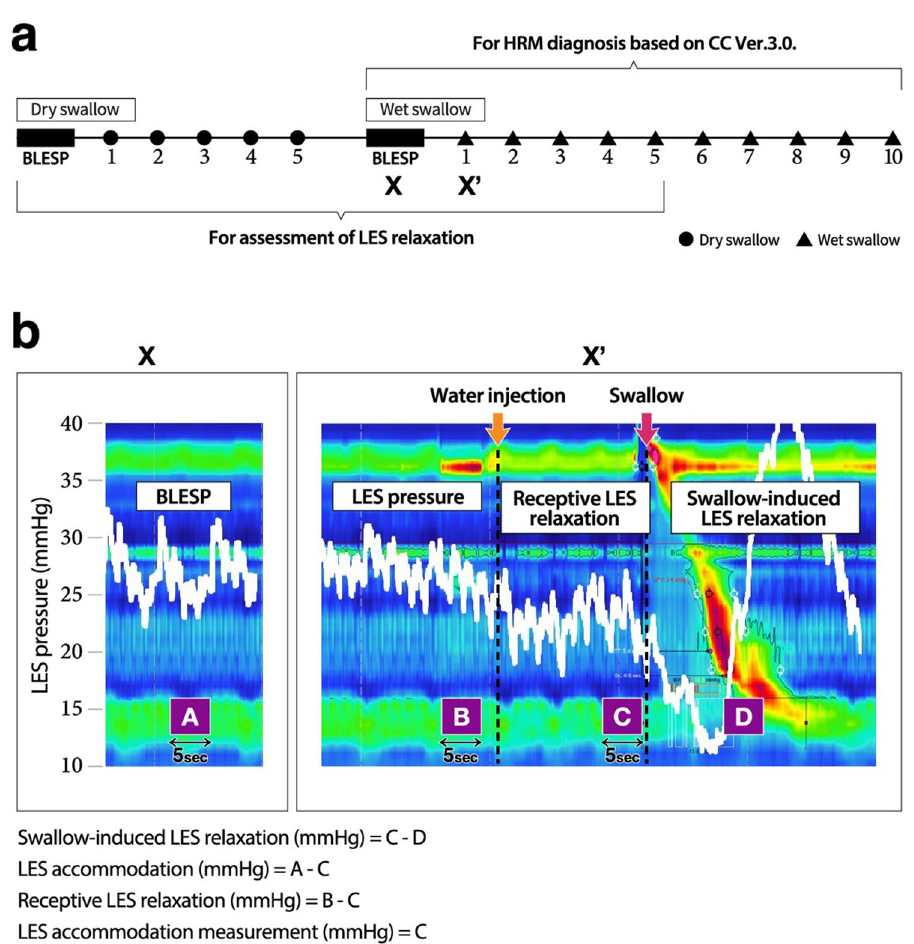
Figure 6. The protocol and original index of the present study. ( a ) The series of the study protocol is shown. After the basal lower esophageal sphincter pressure (BLESP) was obtained, the 5 dry swallows were performed. After the BLESP was obtained again, 10 wet swallows of 5 ml water were performed. ( b ) As for the original index in this study, swallow-induced LES relaxation, LES accommodation, receptive LES relaxation and LES accommodation measurement were determined using the following formulas: C–D, A–C, B–C and C, respectively. Black rectangles indicate the BLESP, and black circles and triangles indicate dry and wet swallows, respectively. A: The BLESP. B: The LES pressure for 5 s just before the injection of 5 mL of water into the oral cavity. C: The LES pressure during pharyngeal water stimulation for 5 s just before each swallow. D: The IRP level of each swallow. In this HRM image, the subject was asked to hold 5 mL water in the pharynx for 15 s longer than usual before swallowing, in order to make receptive LES relaxation easier to